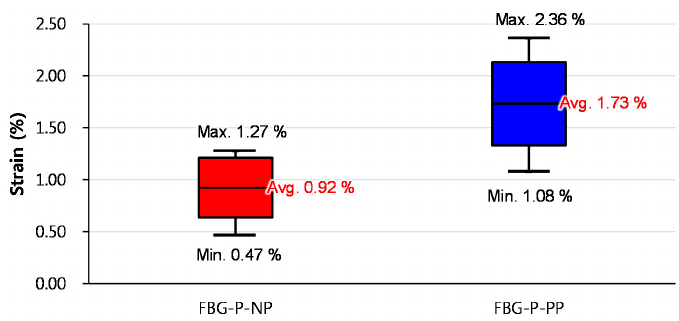
Figure 15. Comparison of maximum strain measurement ranges of FBG sensors.